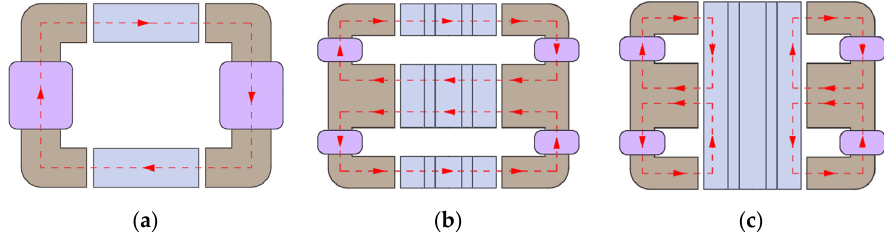
Figure 18. The flux paths of SRM with segmental stators. ( a ) Flux paths in 8/6 C-shape segmental stator SRM; ( b ) Flux paths in 6/4 E-shape segmental stator SRM with triple axial segmental rotor. ( c ) Flux paths in 6/4 E-shape segmental stator SRM with solid axial rotor.